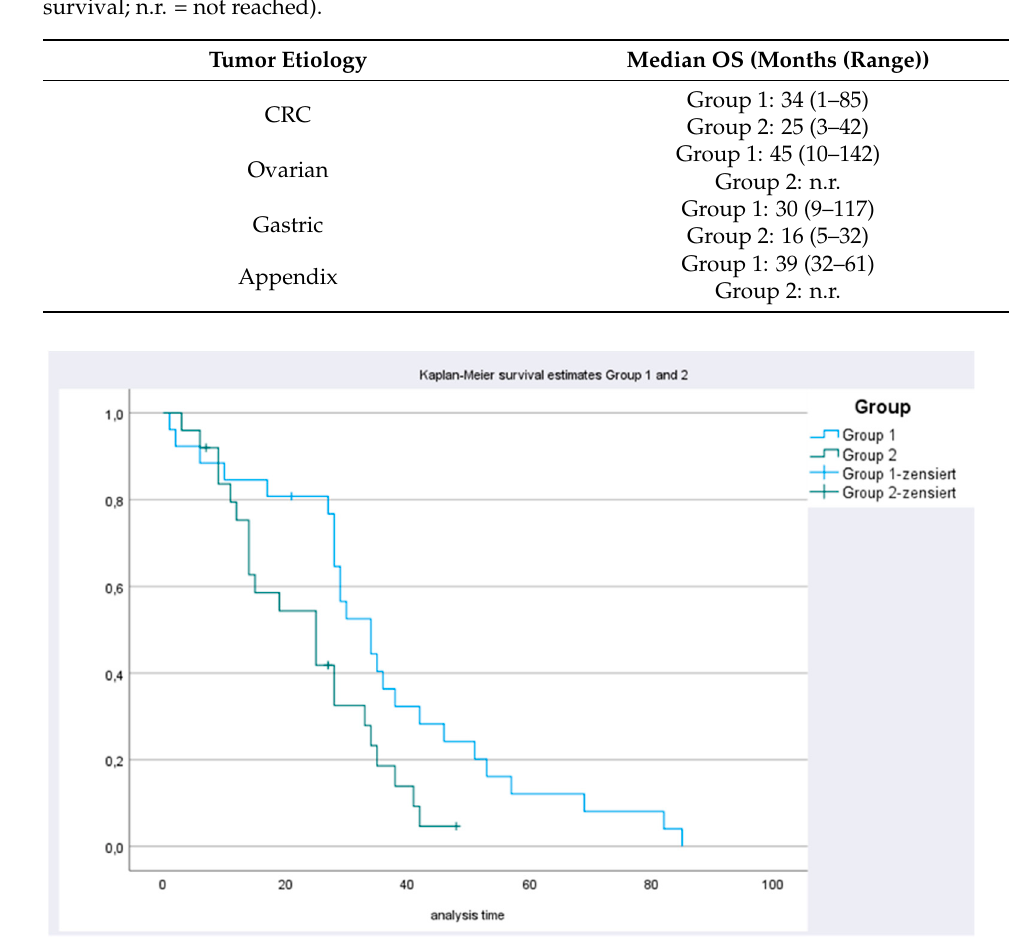
Figure 1. Kaplan–Meier curves for patients with CRC in group 1 and 2.